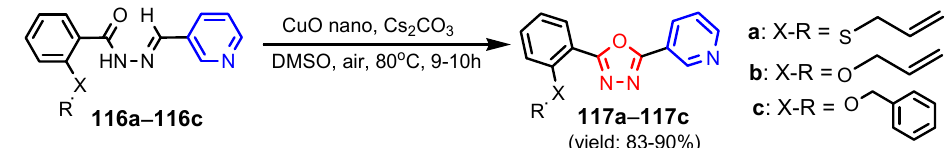
Scheme 25. Synthesis of 1,3,4-oxadiazoles–pyridines 117a – 117c [54]. Krishna et al. [55] synthesized compound 120 in two steps: alkylation of 4-hydroxy- 2H- chromen-2-one 118 to give ester 119 , which by condensation reaction with (Z)-N’- hydroxyisonicotinimidamide under reflux temperature for 24 h, gave 4-[(3-(4-pyridyl)-